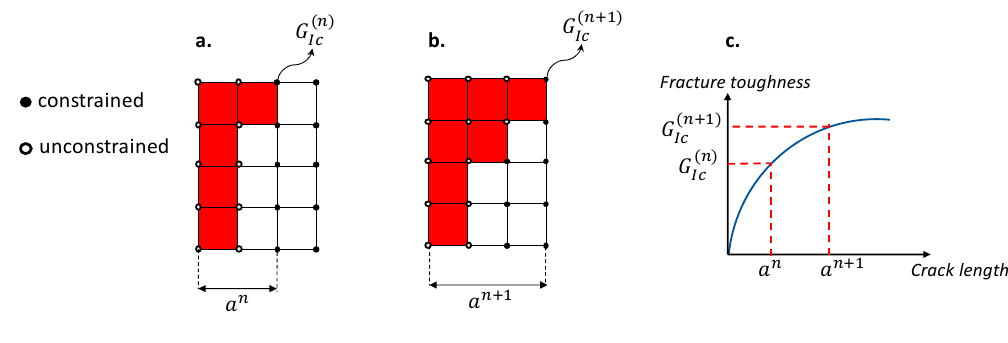
Figure 2. Fibre bridging modulus.